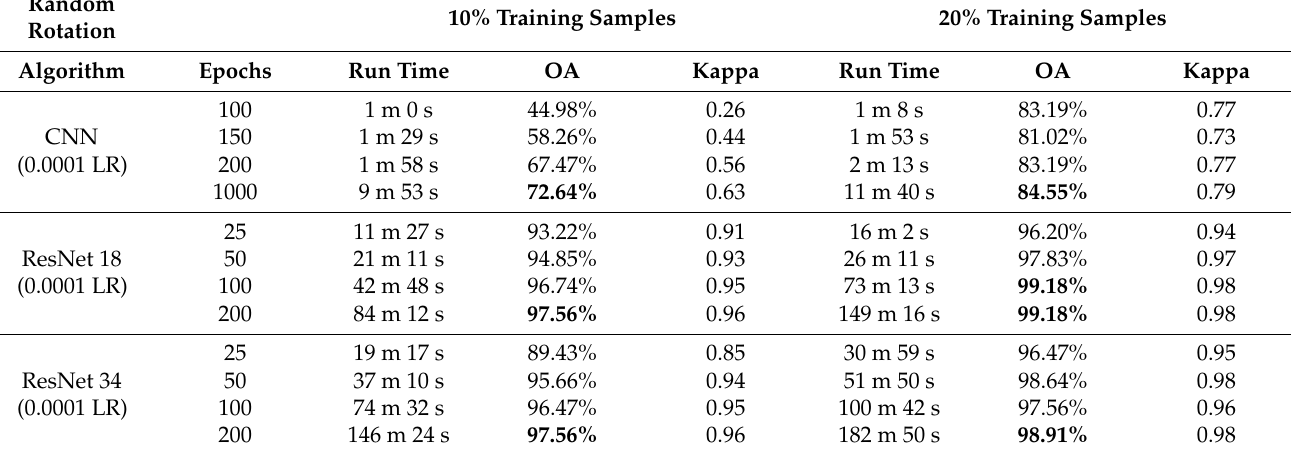
Table 5. Comparison of overall accuracy, Kappa statistic, and run time for CNN, ResNet 18, and ResNet 34 with four different epoch sizes, two different training sizes with random rotation image